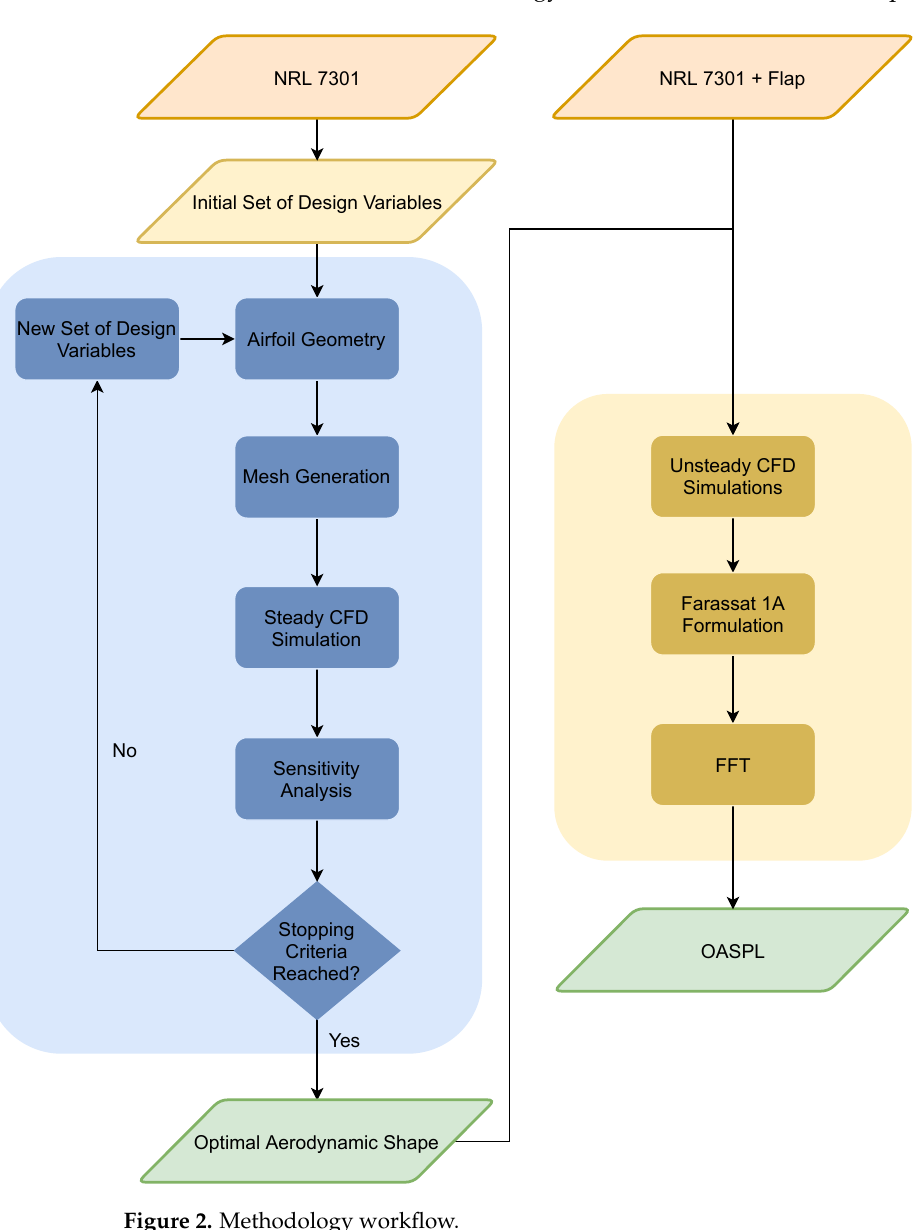
Figure 2. Methodology